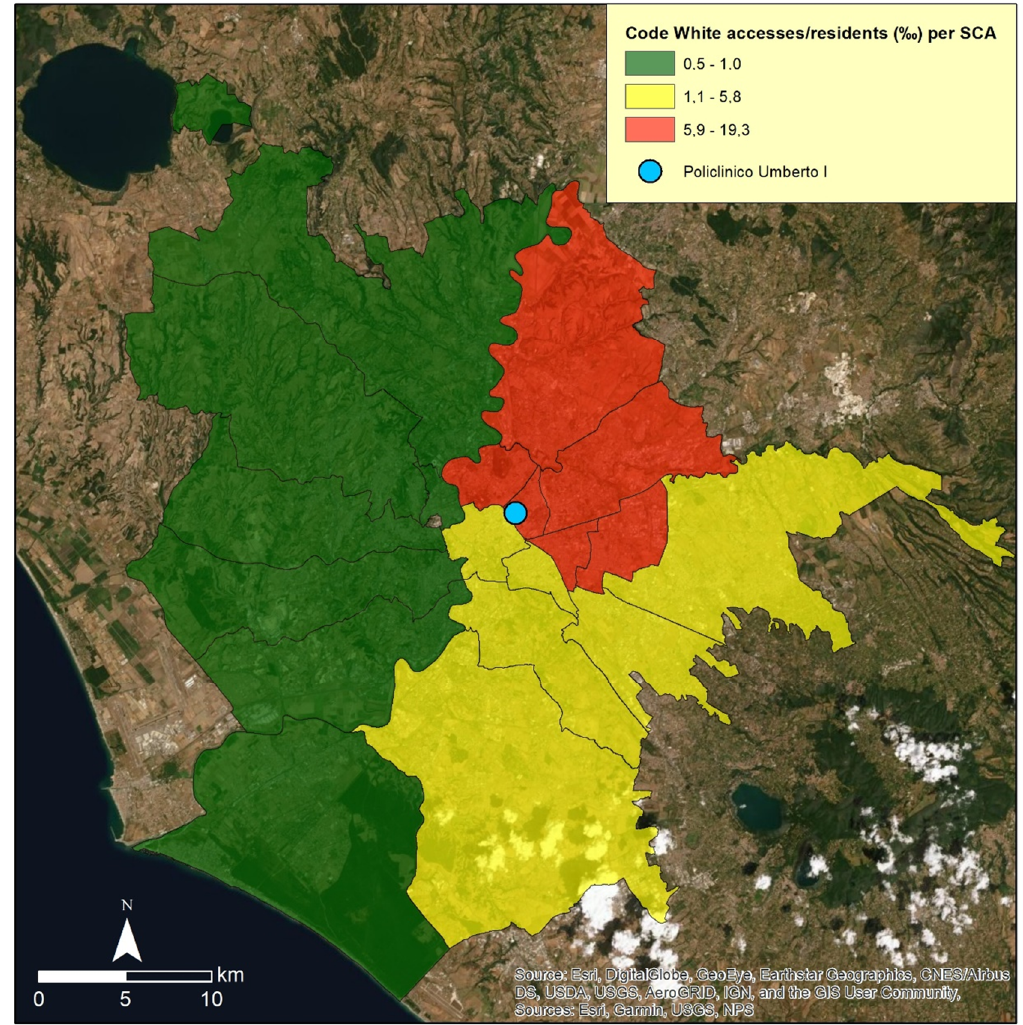
Figure 8. Accesses in code white recorded by the Policlinico Umberto I emergency room in relation to the number of residents, with data aggregated on the basis of sub-municipal areas. Source: authors’ elaboration.